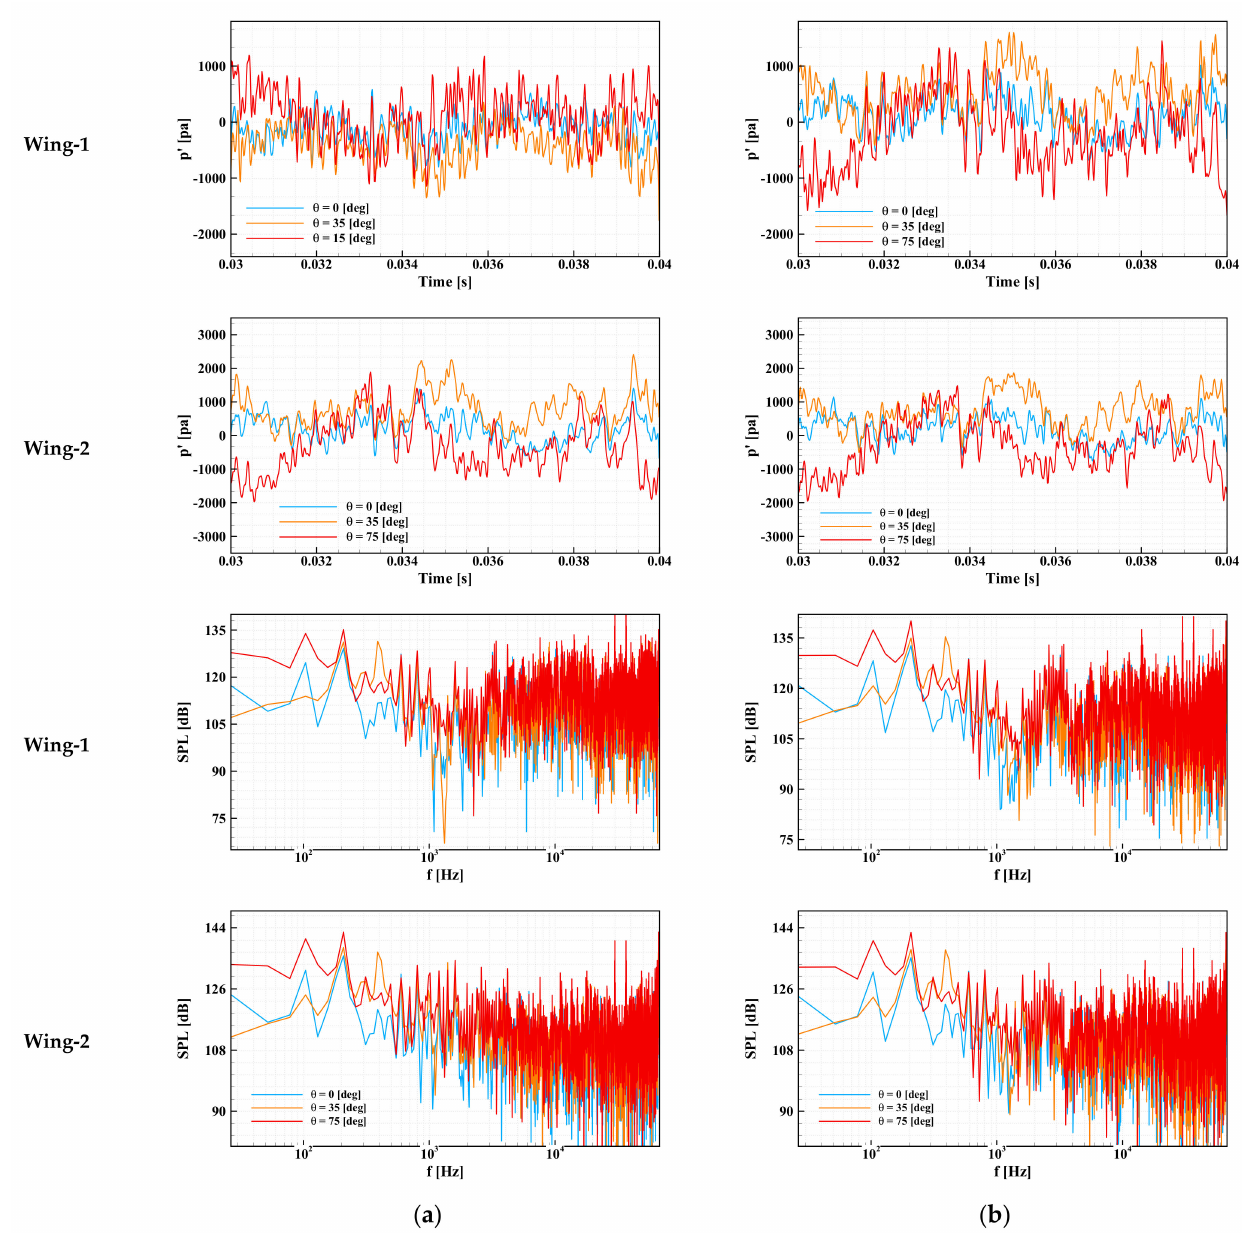
Figure 12. Acoustic pressure fluctuation and sound pressure level on the wings close to: ( a ) wing tip; ( b ) fuselage. The acoustic pressure fluctuation is obviously dependent on the propeller phase, as the unsteadiness imposed on the wing’s load is due to the propeller’s rotation. t = 0.03 s corresponds to the propeller phase angle of γ = 45 ◦